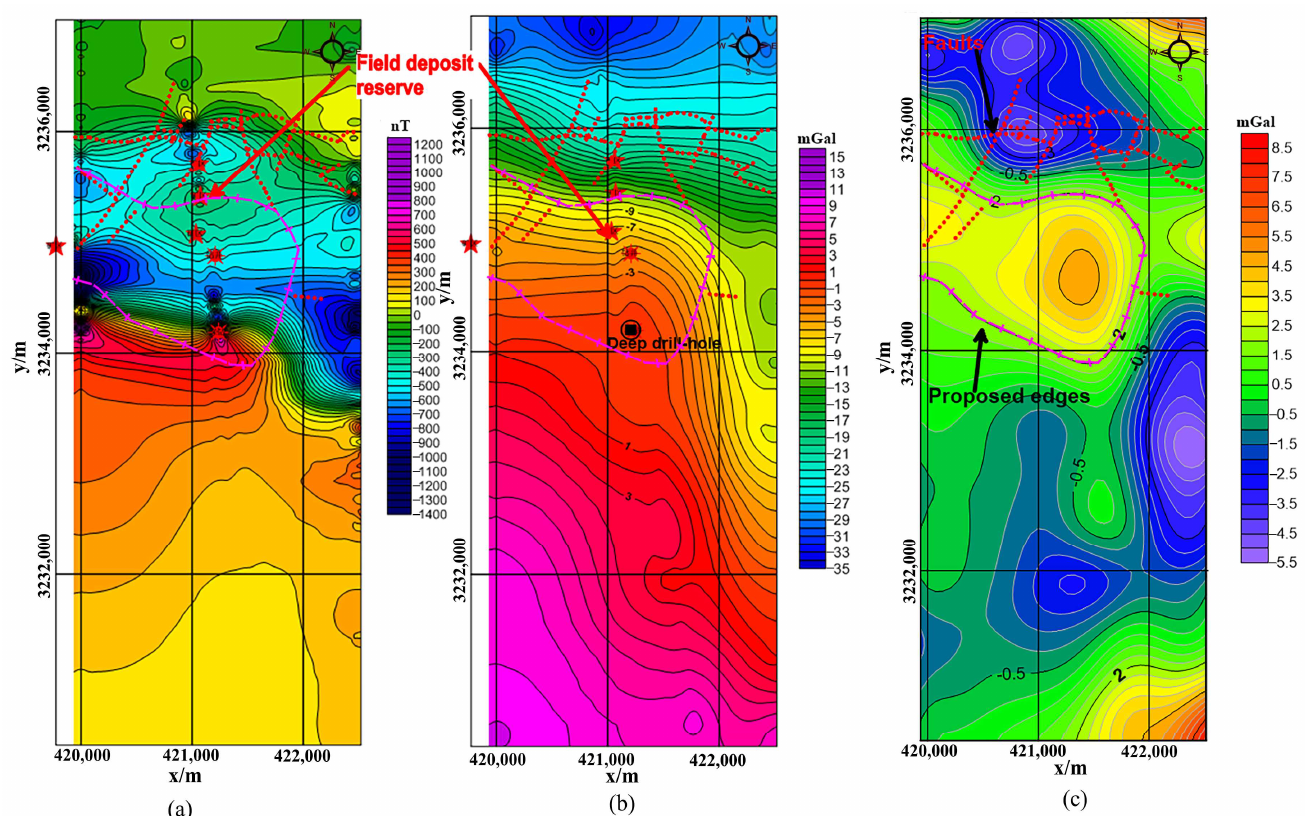
Figure 7. The gravity and magnetic anomaly map of the study area. ( a ) Contour map of magnetic anomaly in the study area; ( b ) contour map of the gravity anomaly; ( c ) contour map of the residual gravity anomaly.